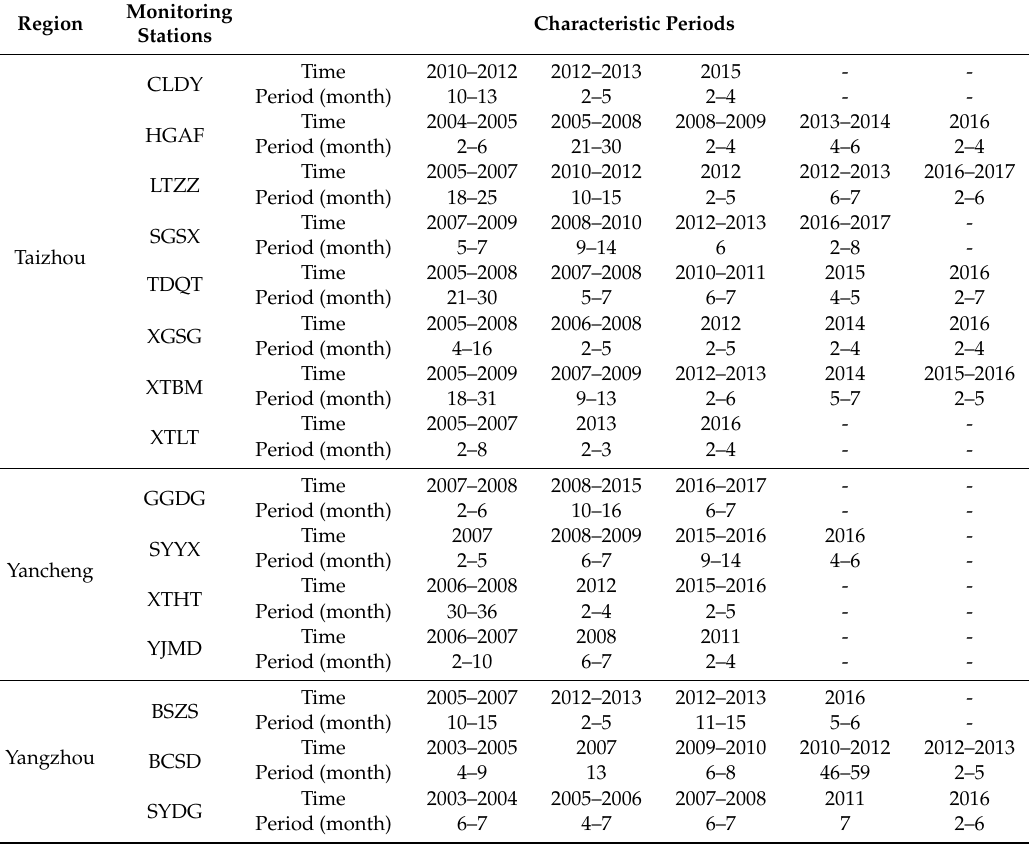
Table 5. The characteristic periods of